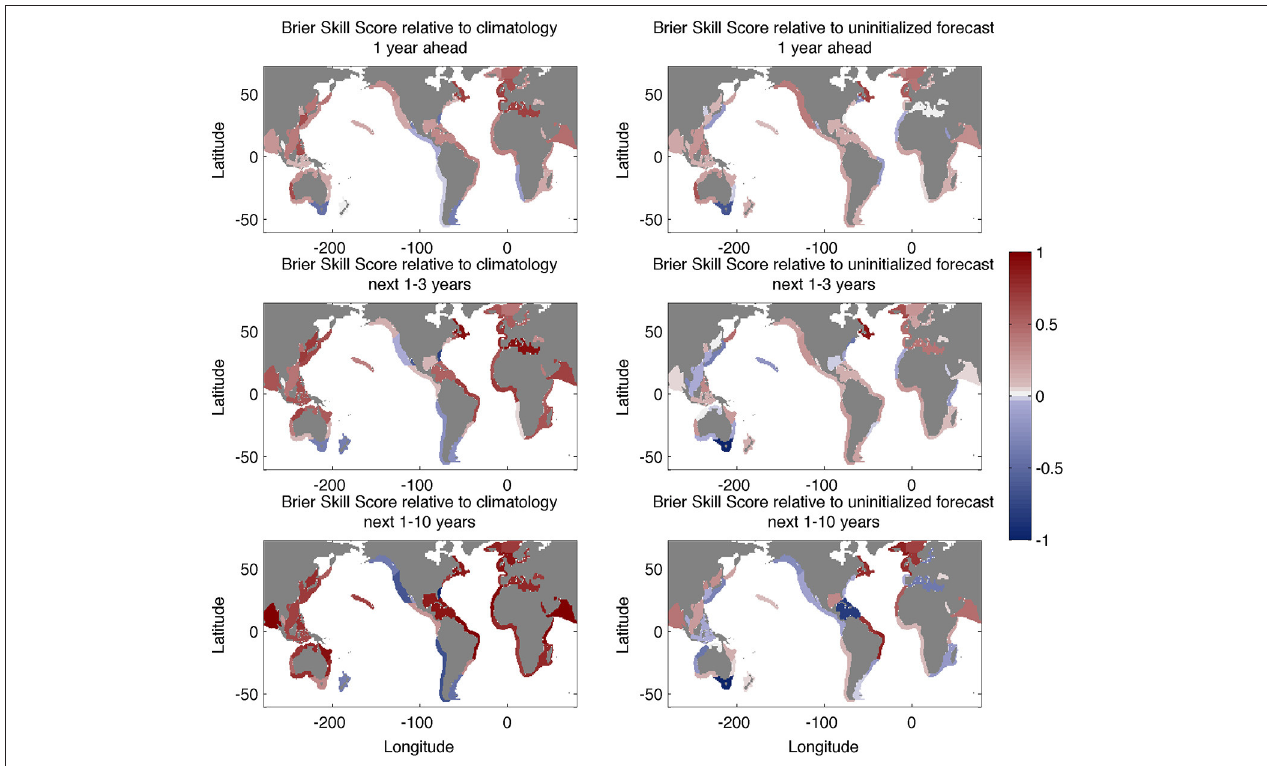
FIGURE 6 | Brier Skill Score (BSS) for upper SST tercile predictions relative to climatology (left) and uninitialized predictions (right) for a 1 year ahead forecast and over the next 3 and 10 years. The BSS ranges from 1 (perfect score) to negative infinity (no skill). Negative scores indicate no additional skill as compared to the reference